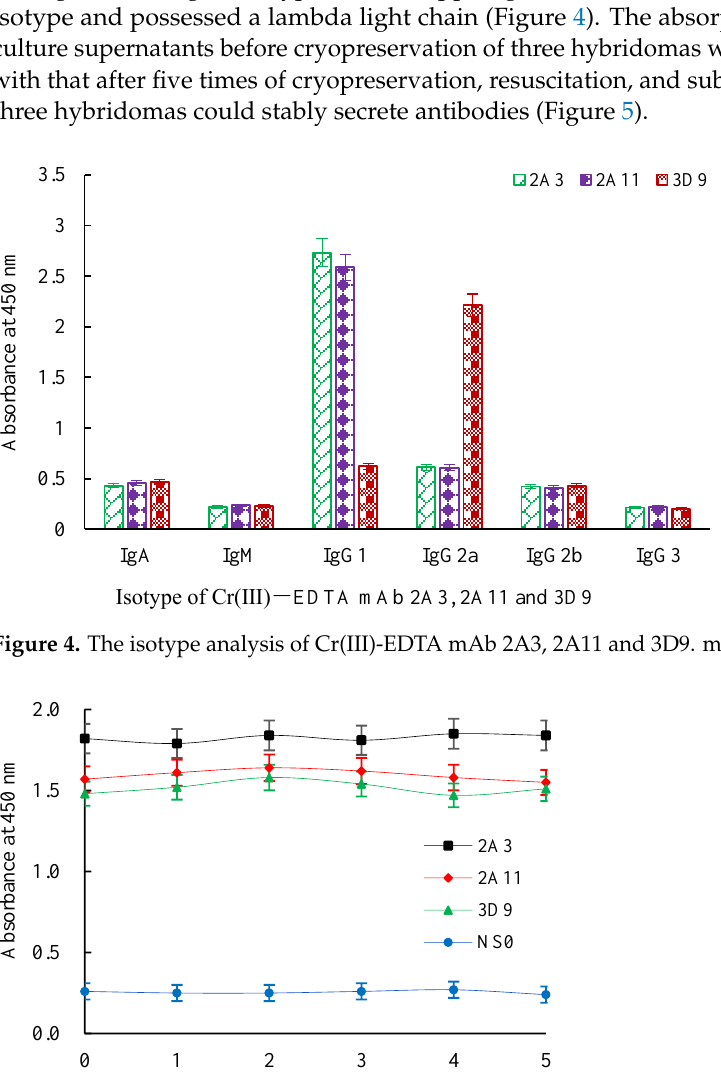
Figure 5. The titers of Cr( Ш ) － EDTA mAbs secreted by three hybridomas after five freeze and thaw cycles.